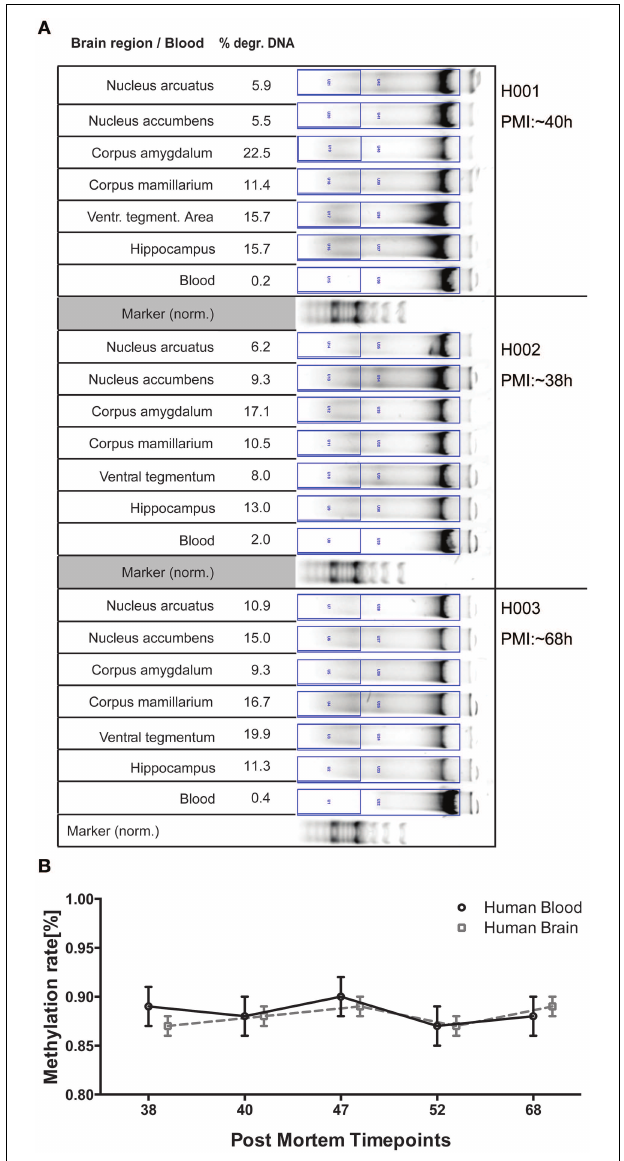
FIGURE 2 | (A) DNA gel electrophoresis for 3 of the six human subjects analyzed for comparison. Degraded DNA was put in relation to total DNA in the respective lane for normalization. (B) Epigenetic variance of the ALDH2 gene for timepoints investigated in human DNA is stable both between blood and brain as well as in regards to variance of measurements. The mean methylation rate (%) of 10 CpGs of 6 brain regions was calculated for 5 post mortem subjects and is plotted against respective PMI for the two tissues analyzed. All error bars are ±